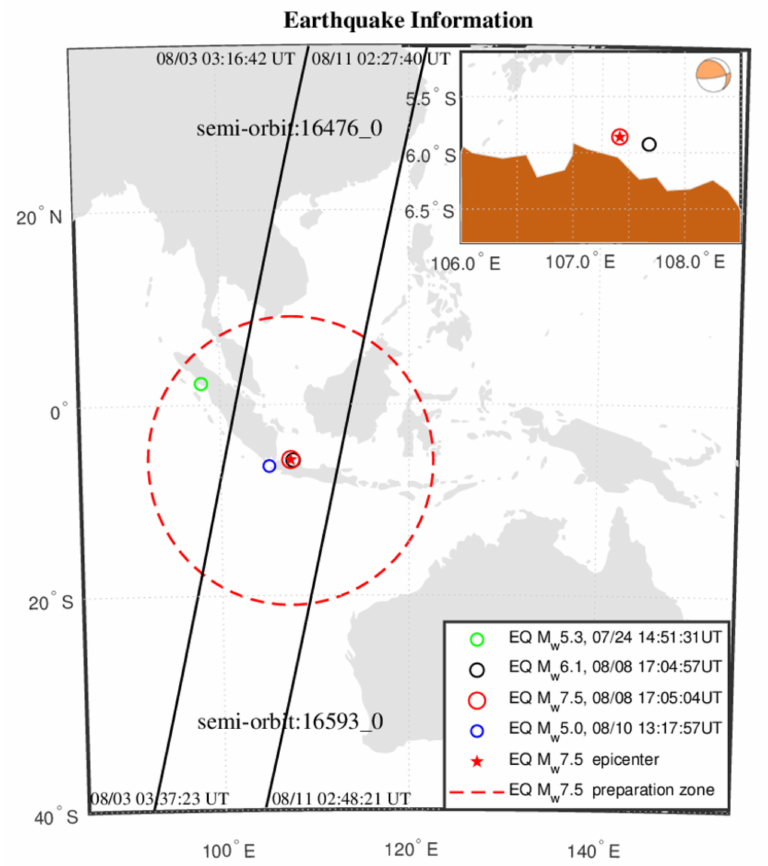
Figure 1. The 8 August 2007 M w 7.5 Jakarta–Java (5.86 ◦ S, 107.42 ◦ E) Earthquake. The red star represents the epicenter of the main shock and the red dashed circle shows the estimated earthquake preparation zone (about 1618.8 km in radius). The local enlarged view in the top right corner illustrates two offshore earthquakes, i.e., EQ- M w 6.1 and EQ- M w 7.5, and the latter is an oblique- reverse type one. The two curves illustrate downward semi-orbits (16476_0 on 3 August and 16593_0 on 11 August) of the DEMETER